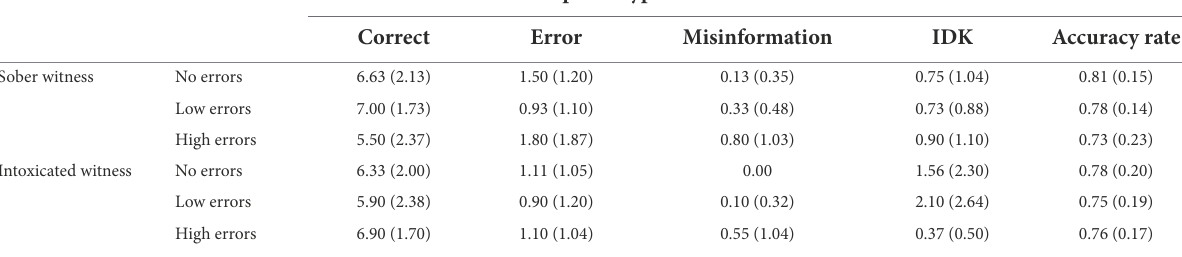
TABLE 3 Means (standard deviations in parentheses) of response type within each